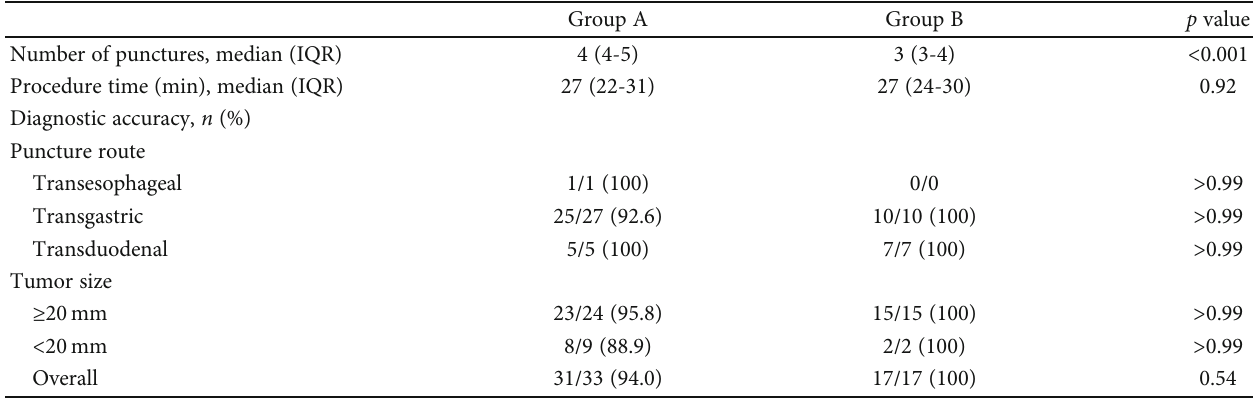
Table 5: Comparison of procedure results and diagnostic accuracy between conventional (Group A) needle and Franseen (Group B) needle groups in malignant lymphoma.